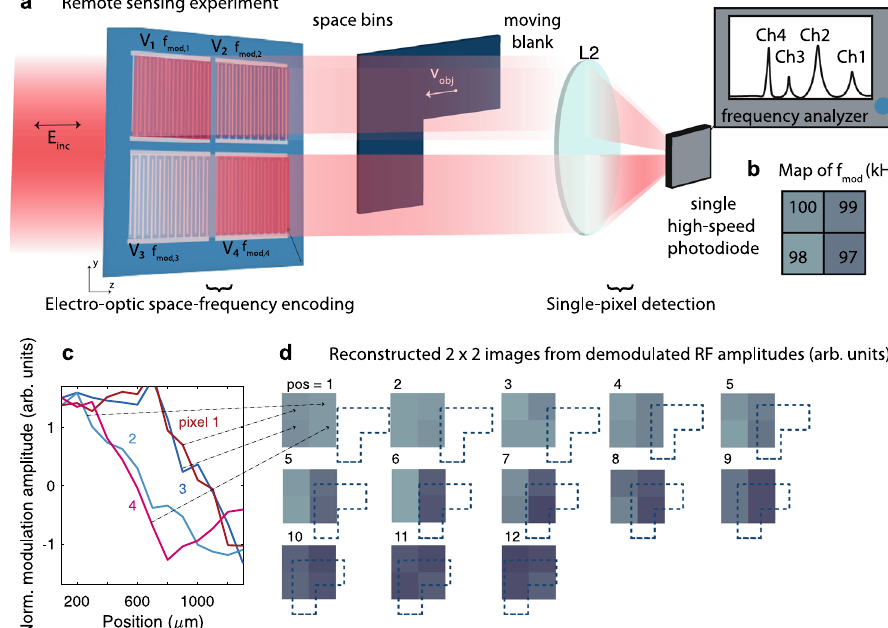
Fig. 6 Multipixel remote sensing by single-pixel detection: encoding space bins onto distinct RF frequencies. a An incident beam is divided into four space bins by the four pixels of the SLM and the light passing through each pixel is modulated with a distinct f mod,n , as shown in b Thereby, a one-to-one correspondence is created between each space bin and a radio-frequency. An intensity measurement of all four channels at one single high-speed detector is demodulated at the individual modulation frequencies to reconstruct the transmission through the environment. In a proof-of-concept experiment, an L-shaped blank is traversing the x - z -plane between the SLM and the single-pixel detector. c Demodulated RF amplitudes are reported as a function of the position of the blank. d These amplitudes are then further bundled to create two-dimensional pictures of the transmitted light. The dotted lines represent the position of the blank with respect to the four space bins, and the intensity of the pixels represent the amplitudes of the demodulated RF fi elds in arbitrary